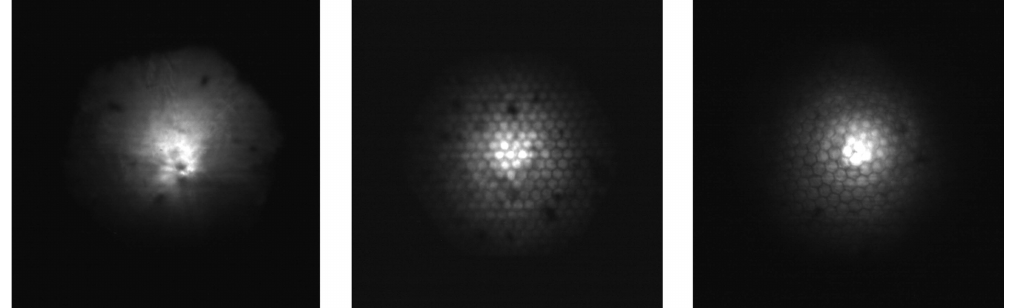
Figure 8 Beam intensity distribution for a primary beam energy of 12 keV for three different polycapillary optics PC-50 (left), PC-236 (middle) and PC-246 (right).